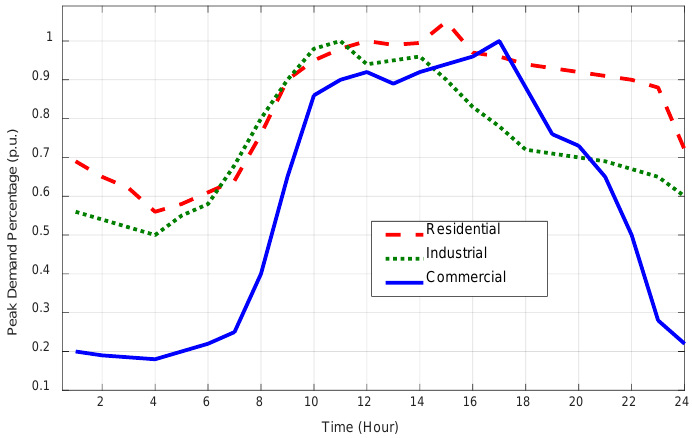
Figure 2. Daily hourly demand curves according to the type of user [43] .